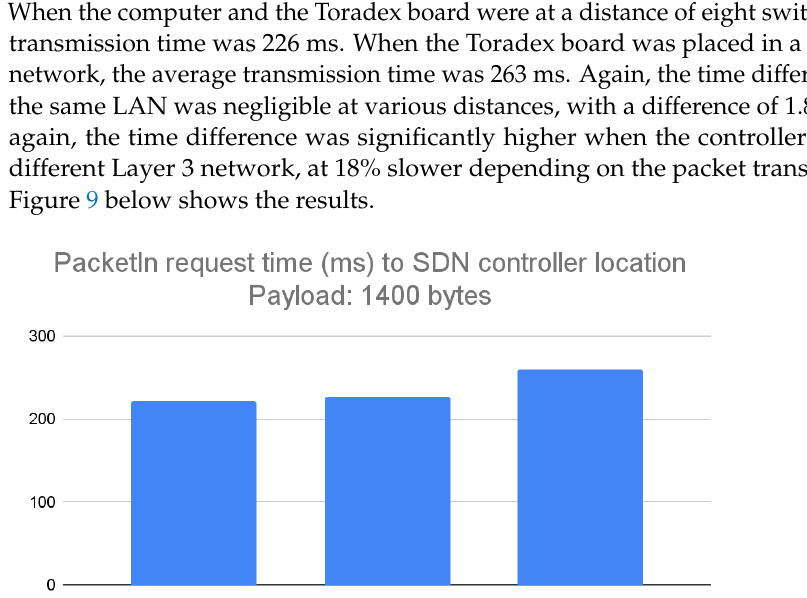
Figure 8. Experimental results of running the design for portability in case of a PacketIn packet having a payload of 1000 bytes, considered a medium payload.